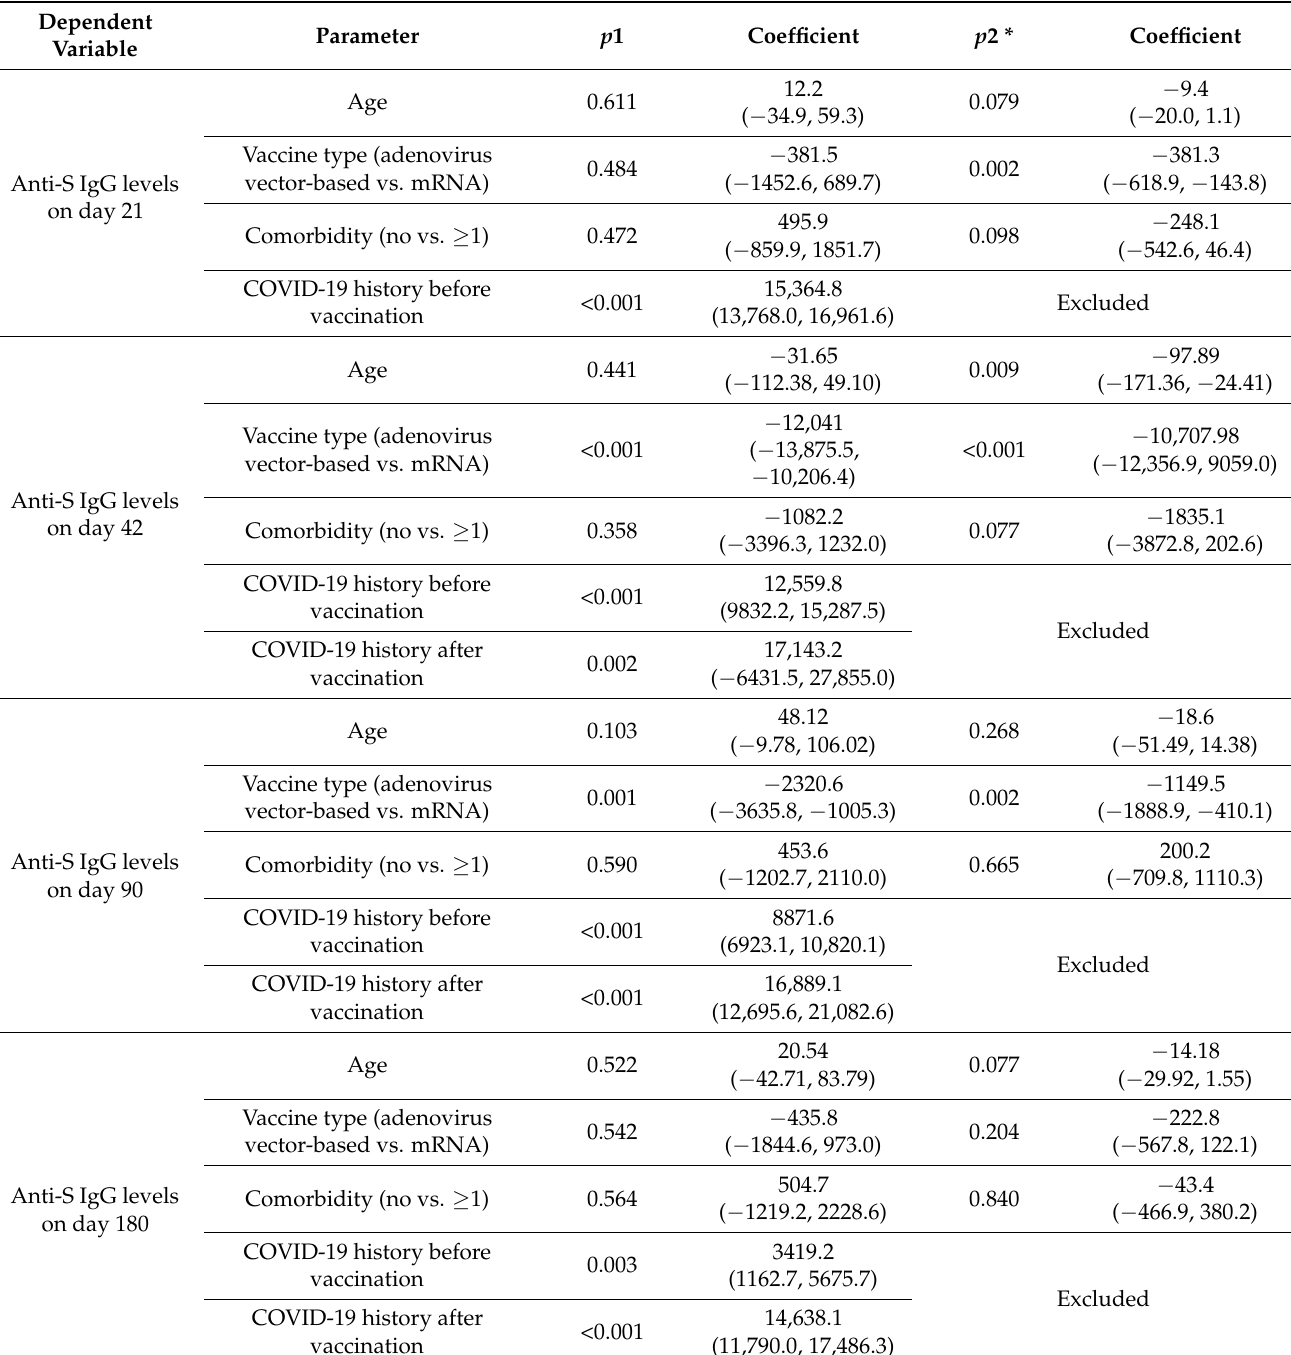
Table 5. Multivariate analyses of anti-SARS-CoV-2 IgG responses after vaccination with